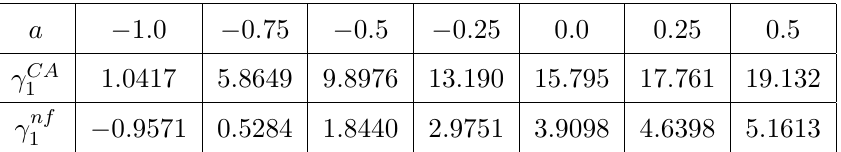
Table 1 . Coe(cid:14)cients of the two-loop soft anomalous dimension as de(cid:12)ned in eq. (2.32).